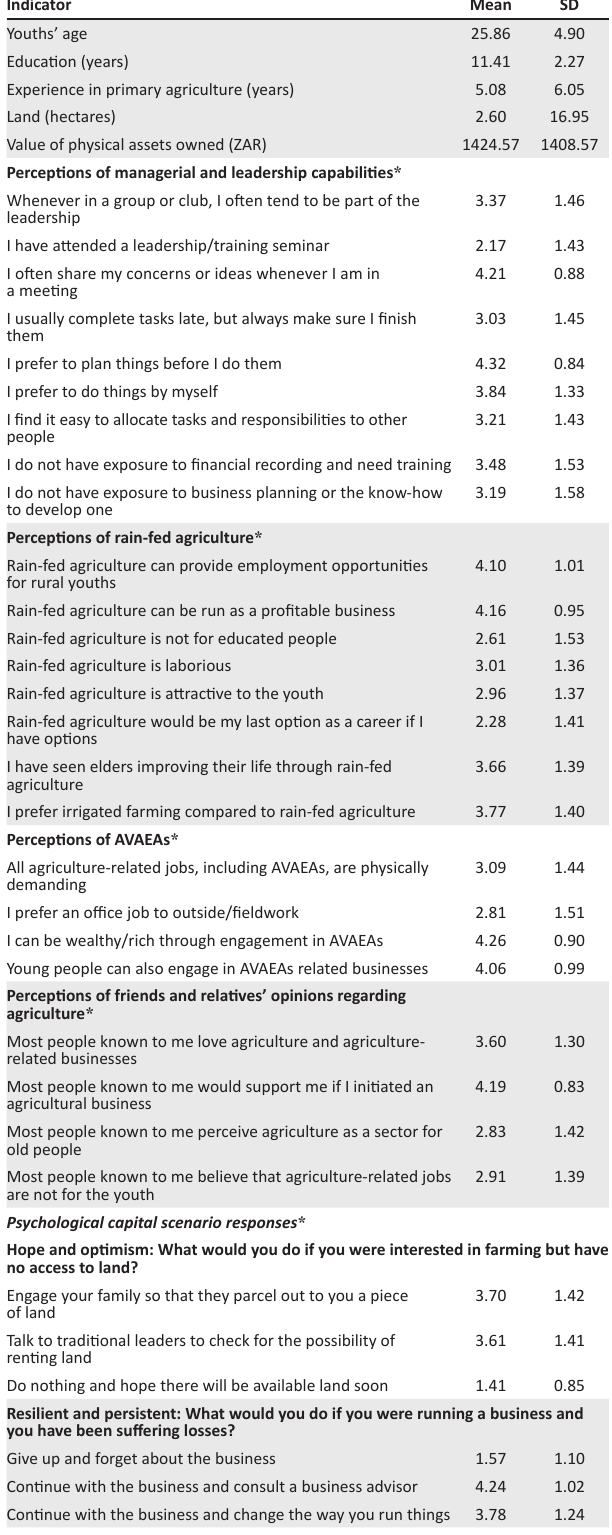
TABLE 2: Descriptive statistics of continuous youth indicators.